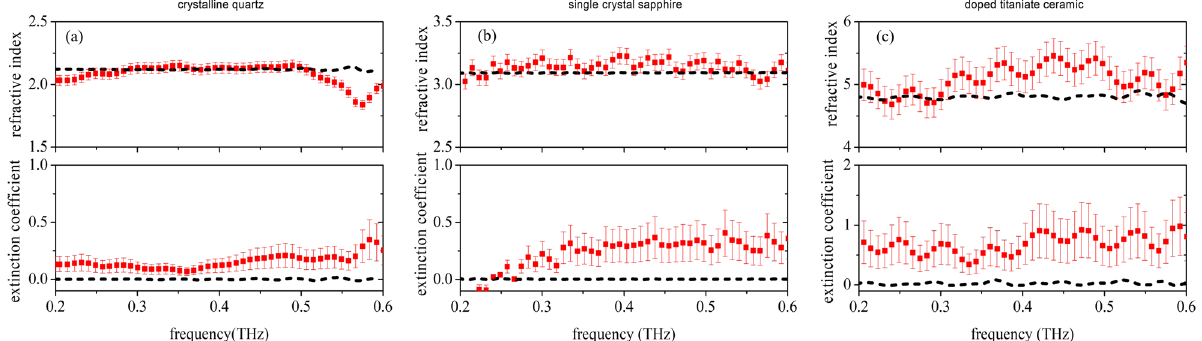
Figure 6. Complex refractive index of ( a ) crystalline z-cut quartz, ( b ) single crystal z-cut sapphire, and ( c ) doped titanate ceramic. Ellipsometric data are shown as red full circles, whereas black dashed lines represent the results of standard TDS measurements using the ellipsometer